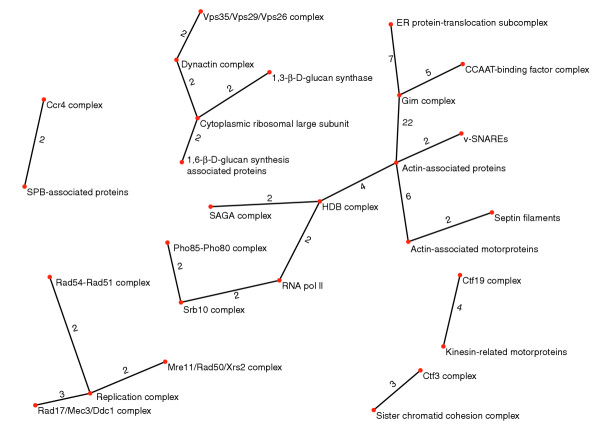
A thematic map of compensatory complexes. Here, nodes represent protein complexes, and a link is drawn between two nodes if there is a significantly large number of inter-complex SSL interactions. Links between compensatory complexes are labeled with the numbers of supporting SSL interactions.